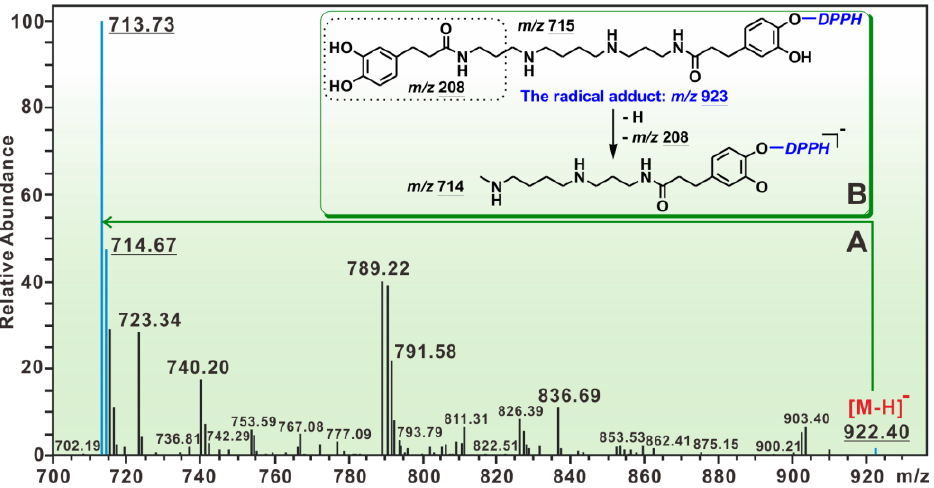
Figure 5. HPLC-MS results of the reaction mixture of kukoamine A with DPPH• radicals: ( A ) main RAF peaks of kukoamine A with DPPH•; ( B ) MS elucidation of radical adduct of kukoamine A with